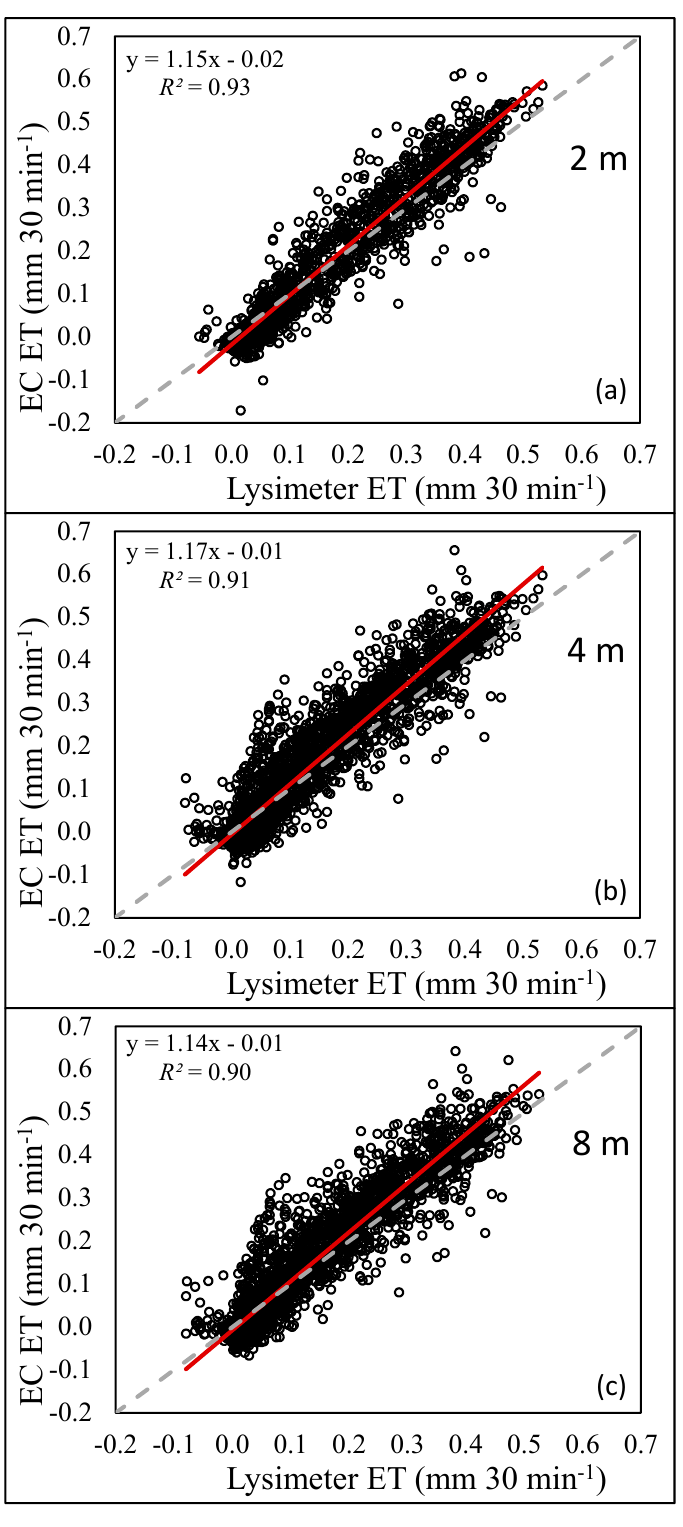
Figure 6. Regression graphs for evapotranspiration from the lysimeter and eddy covariance (EC ET) for systems installed at 2.5 ( a ), 4.5 ( b ), and 8.5 m ( c ). Table 2. Statistics from three eddy covariance systems evaluated against the lysimeter including root mean square error (RMSE), percent RMSE (%RMSE), correlation coefficient ( R 2 ), regression slope, regression intercept, and statistical p-value.